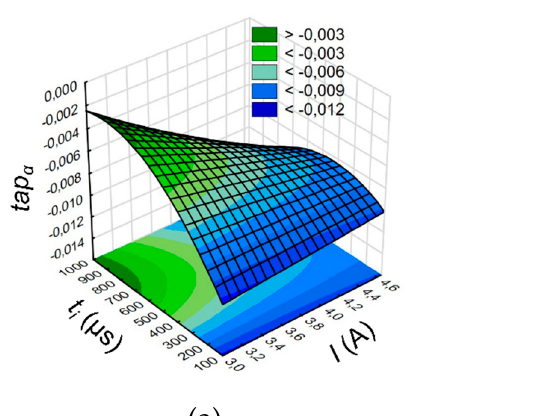
Figure 6. Relationship between the drilling speed v and the pulse time t i and ( a ) current amplitude I , U = 100 V and ( b ) discharge voltage amplitude U , I = 3.83 A.